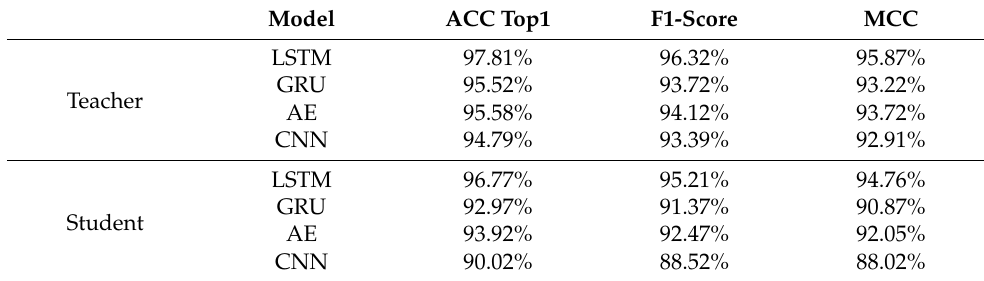
Table 7. Final experiment